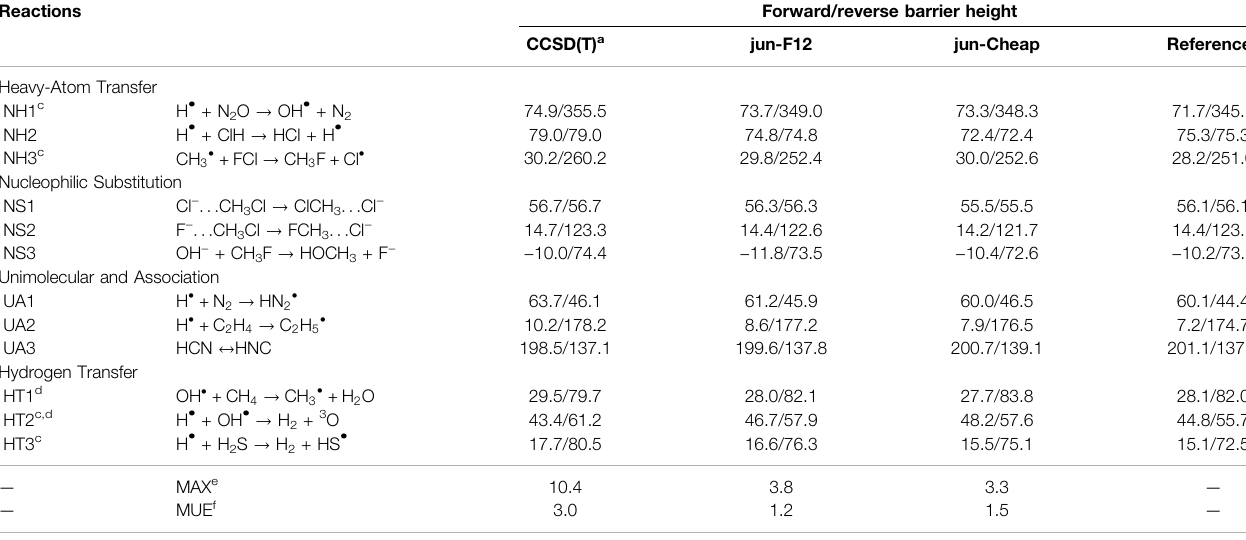
TABLE 2 | Computed equilibrium barrier heights for NH, NS, UA and HT reactions from the DBH24/08 database at different levels of theory. All values are in kJ/mol. Reactions